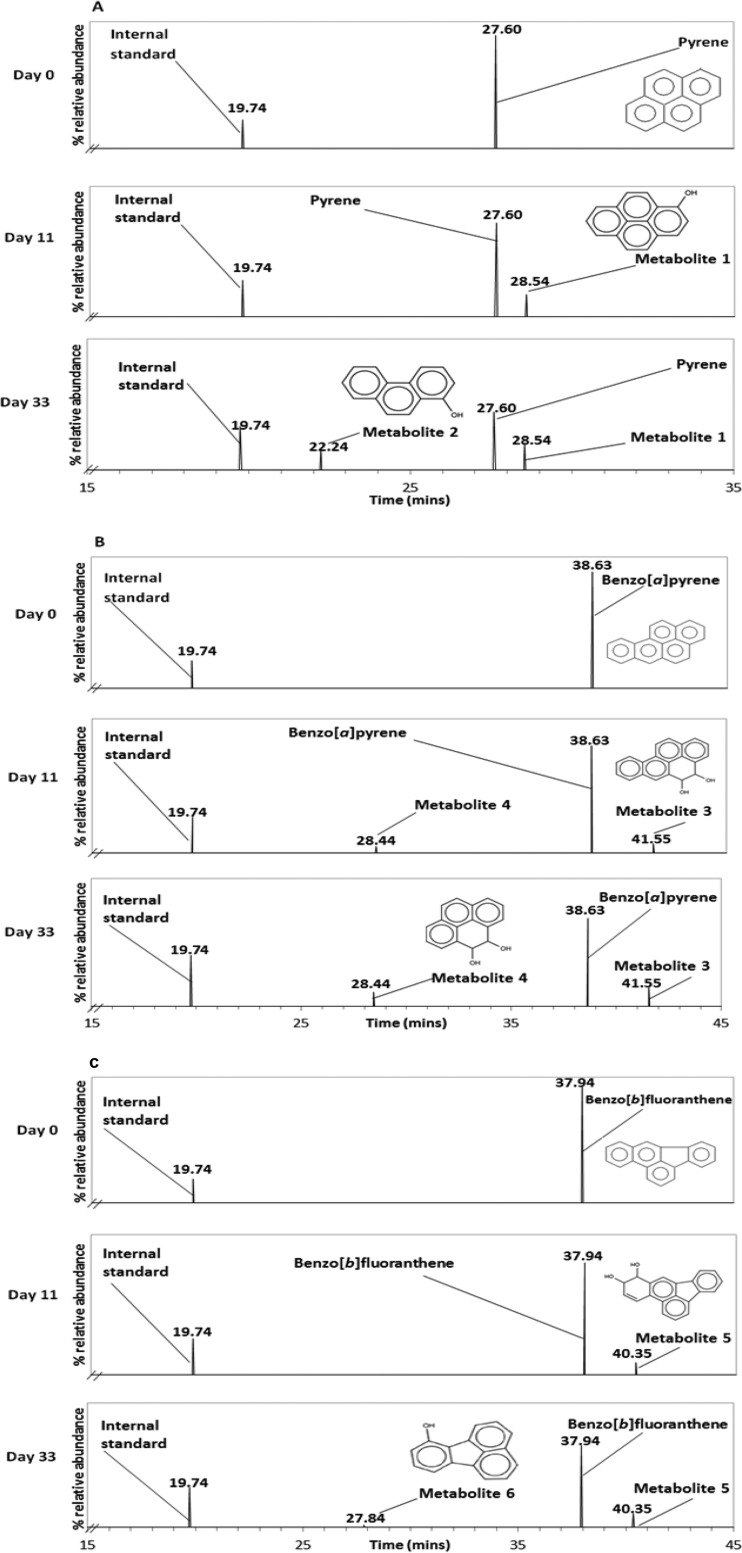
Gas chromatograms showing the transformation of the three HMW-PAHs over a 33-day incubation period by the microbial community derived from sample TPW. Enrichments were grown on Pyr (A), BaP (B), and BbF (C). There is a decrease of the Pyr (retention time [RT], 27.60 min), BaP (RT, 38.63 min), and BbF (RT, 37.94 min) peaks and the appearance of secondary and tertiary peaks associated with tentative metabolites.